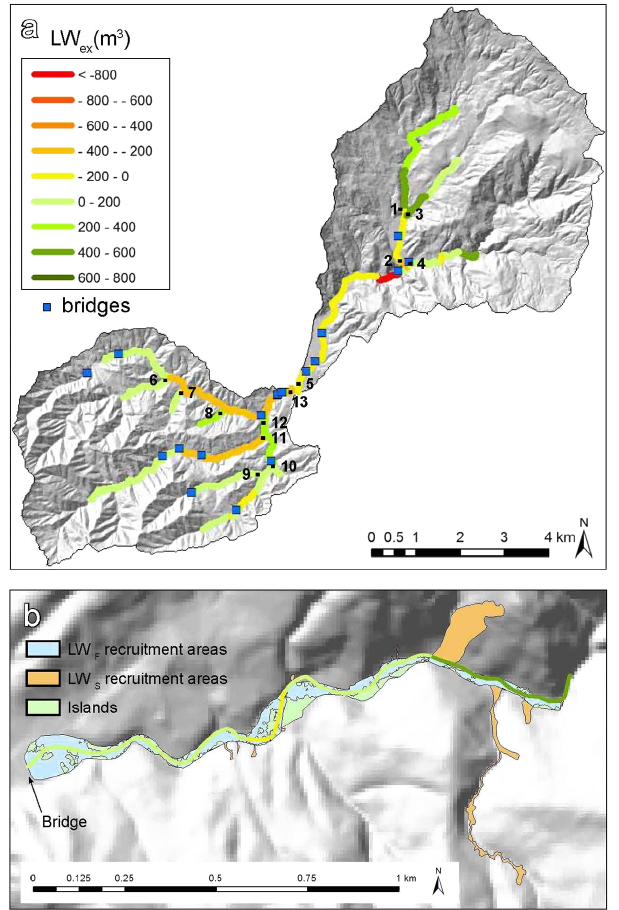
Figure 7. (a) LW exported from each reach. Numbers identify the catchments: 1 Casserola, 2 Casserola, 3 Suvero, 4 Veppo, 5 main Gravegnola, 6 Pogliasca, 7 Redovego, 8 Sottano, 9 Ginepro, 10 Benoia, 11 Redarena, 12 Cassana, 13 main Pogliaschina. (b) De- tail of the Veppo Creek with the LW exported (same symbol and legend of a ) and the map of the areas where LW has been recruited, as well as the remaining vegetation islands.